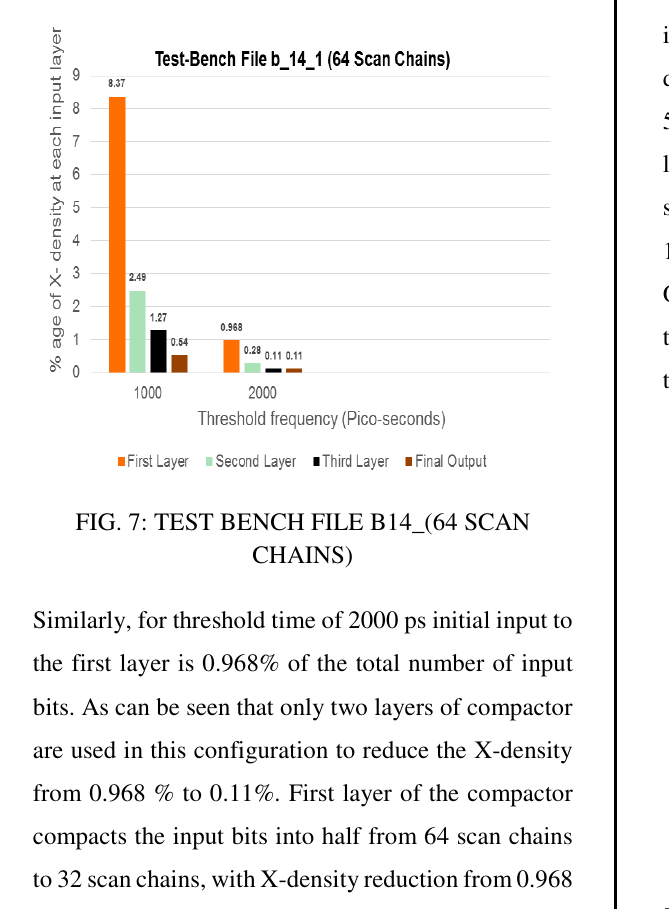
FIG. 8: TEST BENCH FILE B14_1(32 SCAN